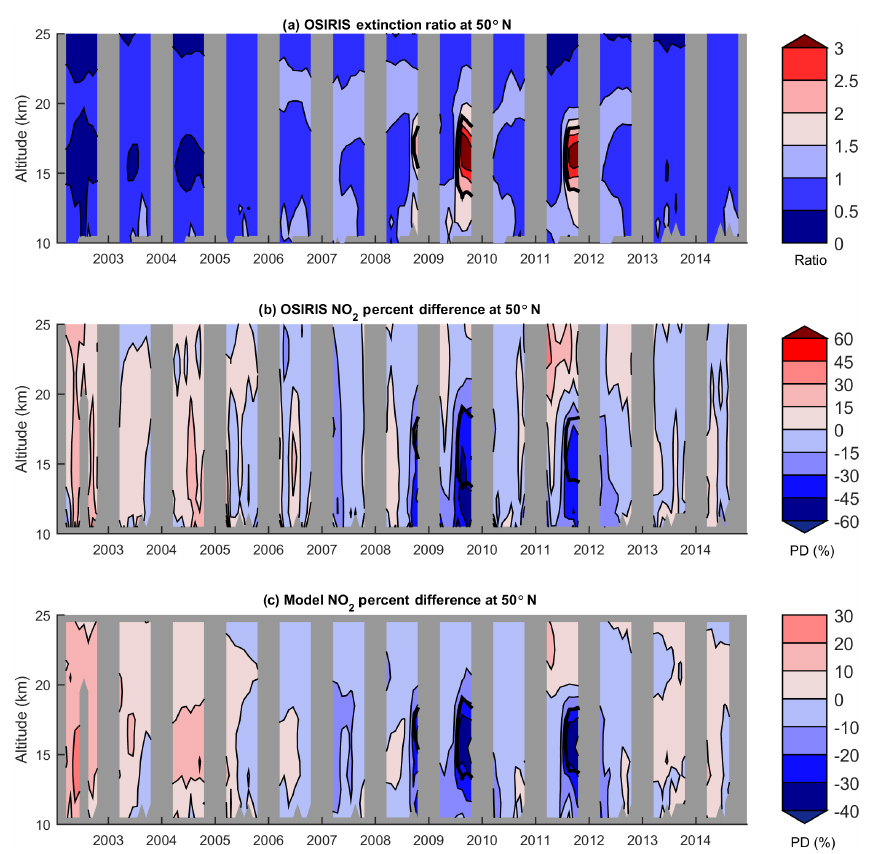
Figure 7. Profiles of aerosol extinction ratio and NO 2 percent difference at 50 ◦ N. Time series of (a) OSIRIS extinction ratio, (b) OSIRIS percent difference NO 2 relative to background levels, and (c) modeled percent difference NO 2 relative to background levels. Note that different color-scale ranges are used for the OSIRIS and model percent differences. The thick black contours are for extinction ratios =